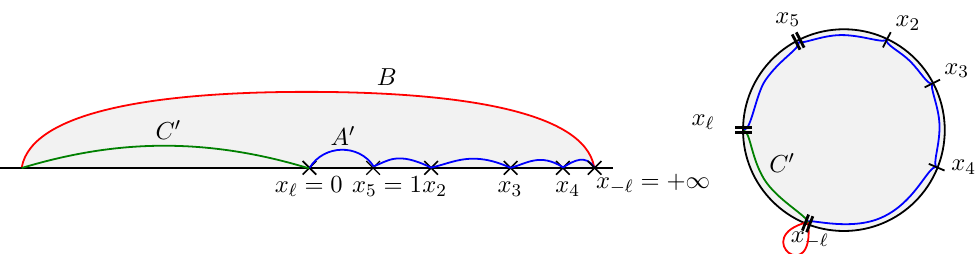
Figure 3 . The right-hand side integration contour of (cid:12)gure 2 is equivalent to the one on the left-hand side here, which is equivalently represented in a disk picture on the